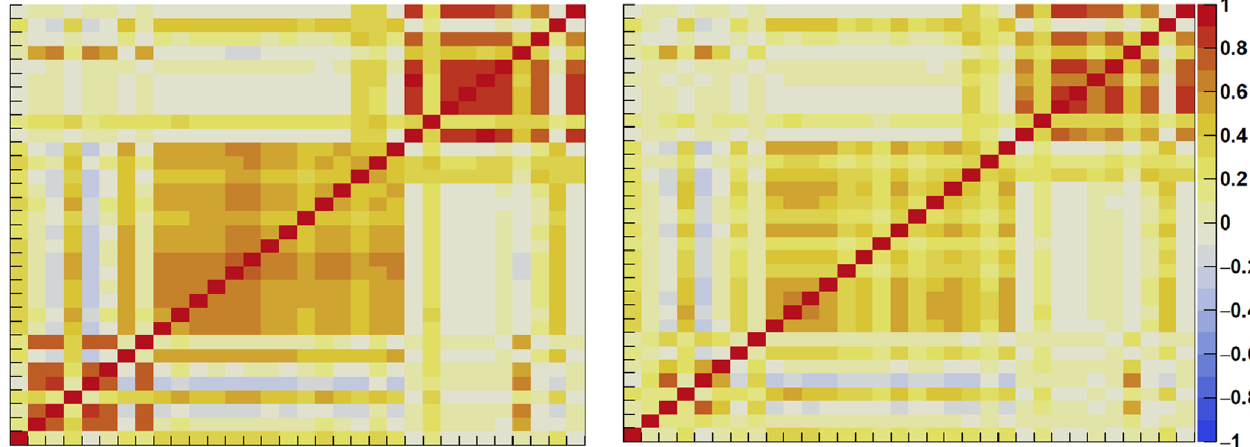
Fig. 7. The correlation matrix, for Exp.2, of the N ð A Þ without the additional dispersion uncertainties, on the left, and with, on the right. X and Y labels are identical to Figure 4 (top).